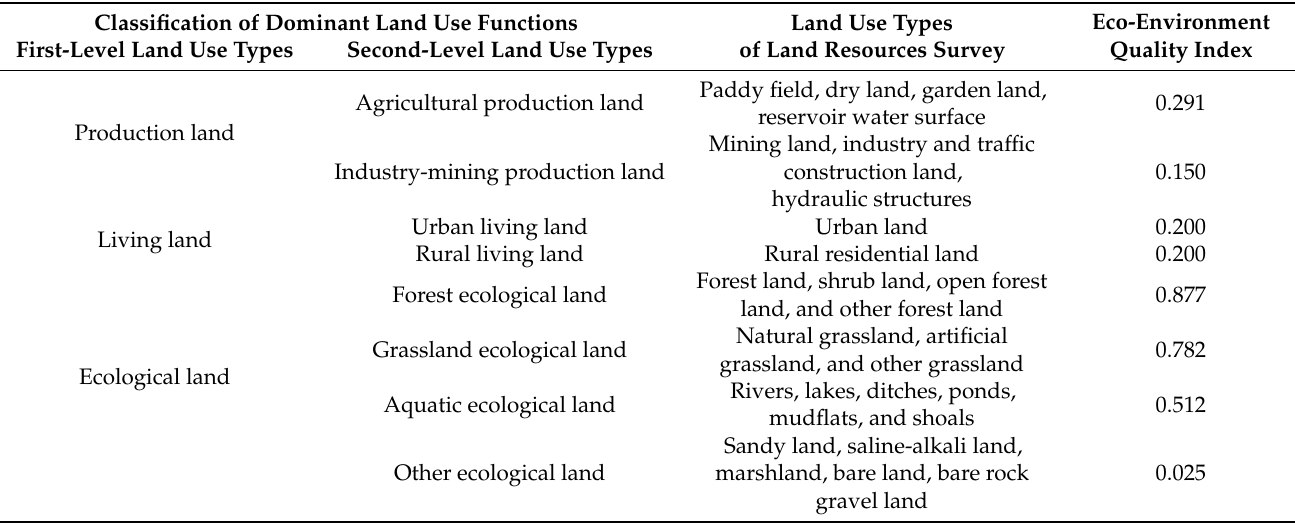
Table 1. Classification of the dominant land use functions and the eco-environment quality index. Classification of Dominant Land Use